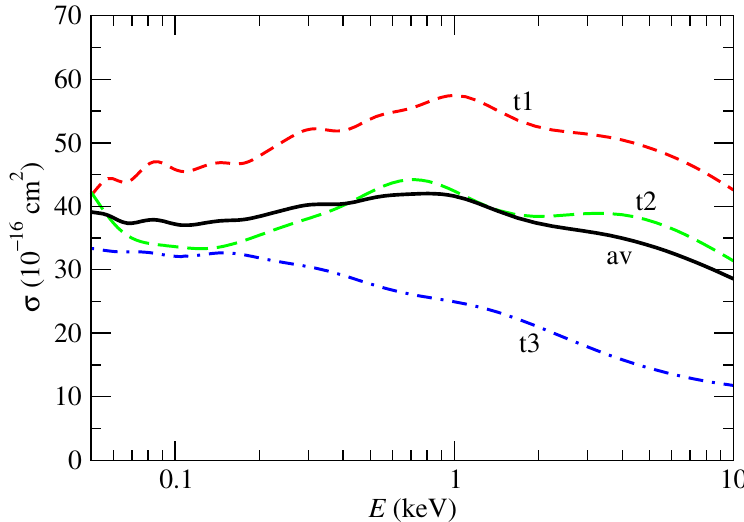
Figure 3. Total single charge transfer cross section in collisions of protons with uracil molecules as functions of the collision energy. Broken lines correspond to the averages of the subfamilies within a family, Equations (3)–(5), labeled in the figure; the solid line is the average of the three families and corresponds to the orientation average of Equation (6).